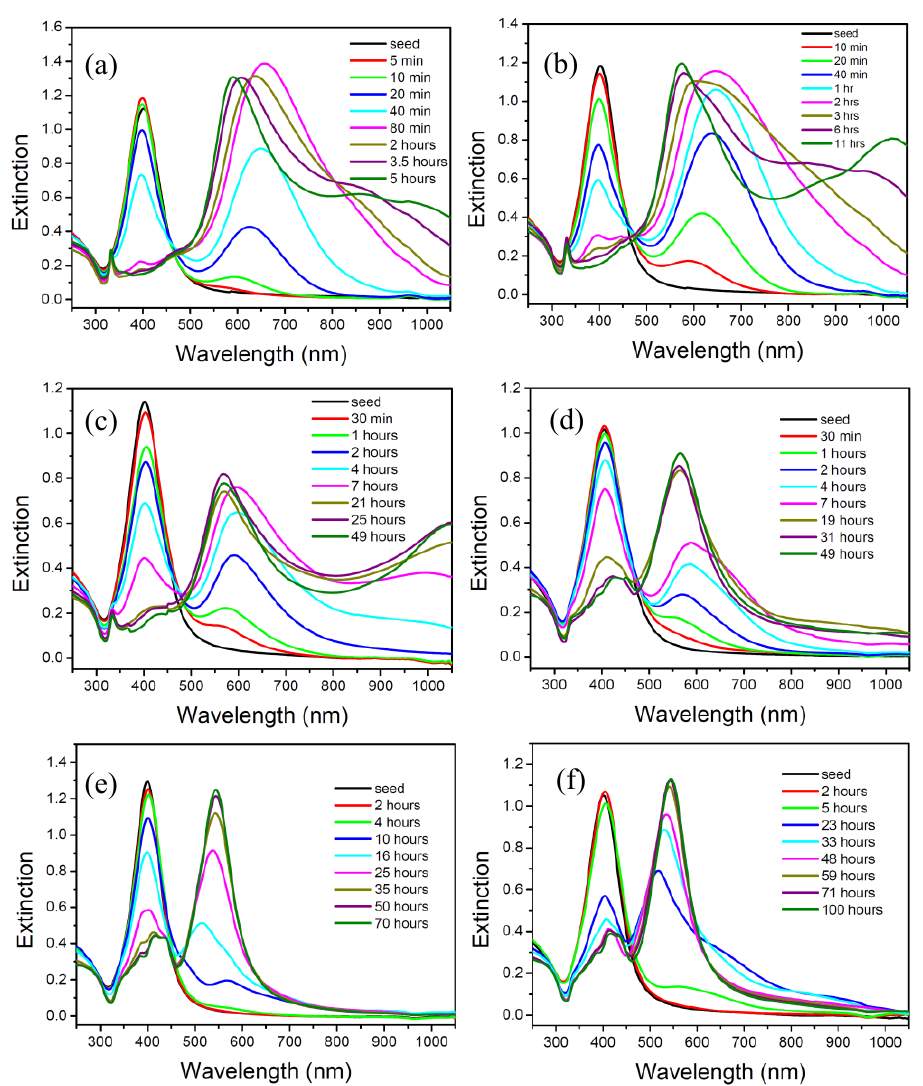
Figure 4. Time-dependent extinction spectra of silver colloids synthesized at